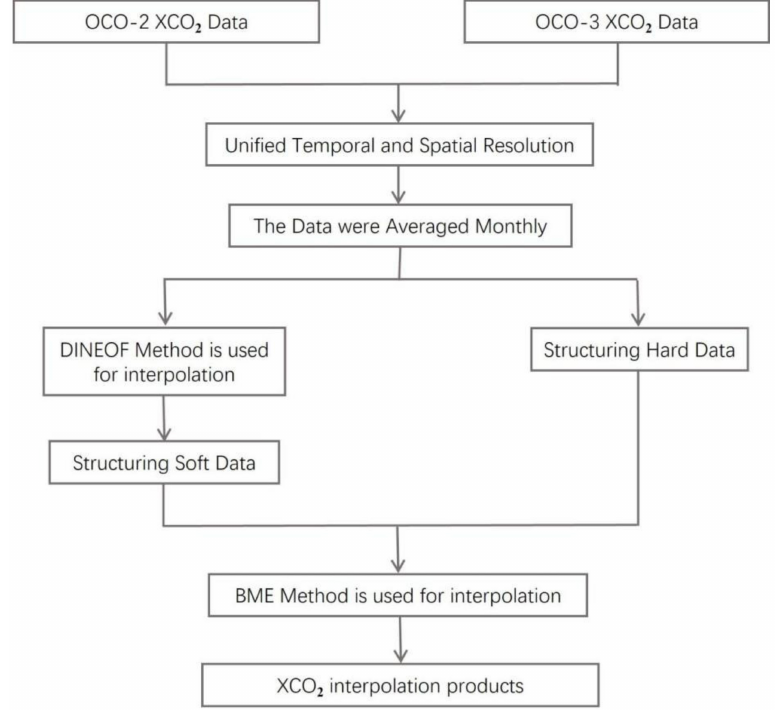
Figure 3. Construction Chart of the